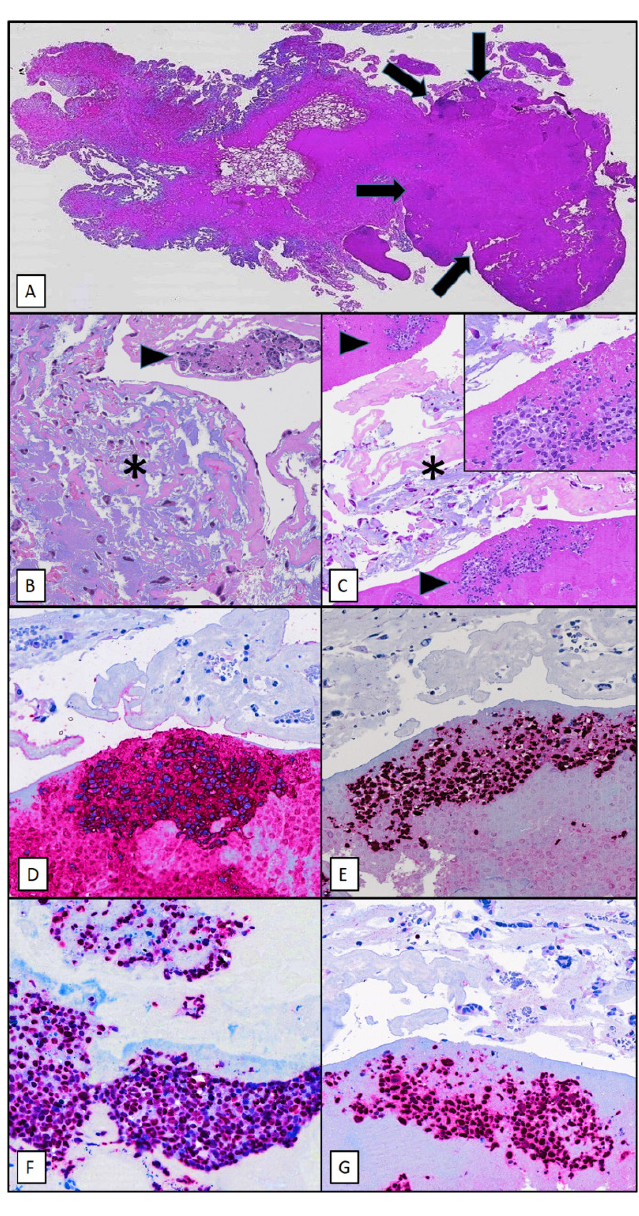
Fig. 3 - A, B, C: Morphological features of the lesion. Whole-mount section of myxoma, with villous surface and a superficial fibrinous cap (arrows) containing lymphoid aggregates (A, haematoxilin- eosin). The myxoma consists of a translucent loose matrix containing scattered stellate cells (asterisk). The lymphoid cells embedded in fibrinous material (arrowhead) are large-sized and atypical (B, C, inset, haematoxilin-eosin). D, E, F: Immunophenotypic features of fibrin- associated diffuse large B-cell lymphoma. The atypical lymphoid cells have a B-cell phenotype, being positive for CD20 (A) and PAX5 (B), are diffusely positive for EBV/EBER (C) and have a high Ki67 proliferation index (D), in contrast to the myxoma cells (D, upper half), which are almost